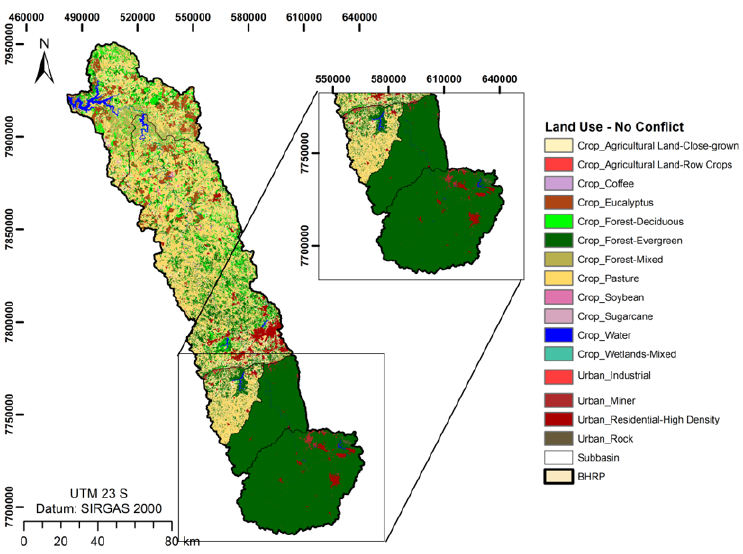
Figure 14. Scenario No Con fl ict for HRUs upstream of the failure.